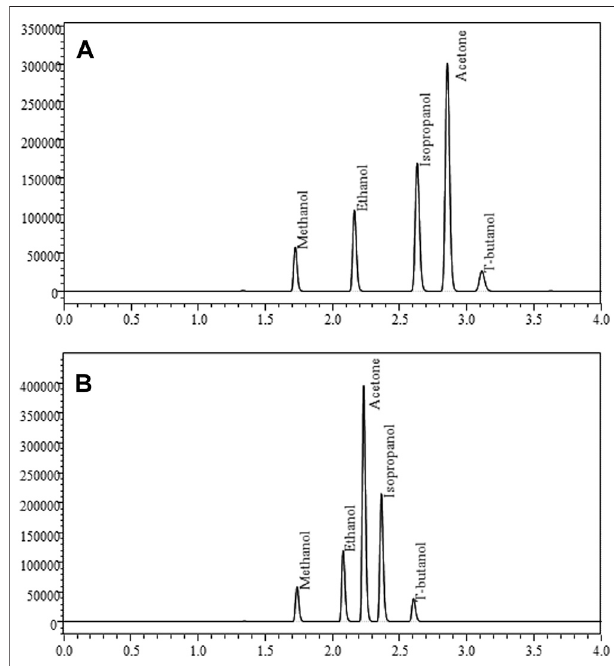
FIGURE 4 | GC-FID chromatograms produced from quantitation of methanol, ethanol, isopropanol, and acetone using t-butanol as an internal standard. Figure A is a standard chromatogram produced by FID 1, and Figure B is a standard chromatogram produced by FID 2. Differences in analyte retention times are produced by the different separation techniques of the two chromatographic columns